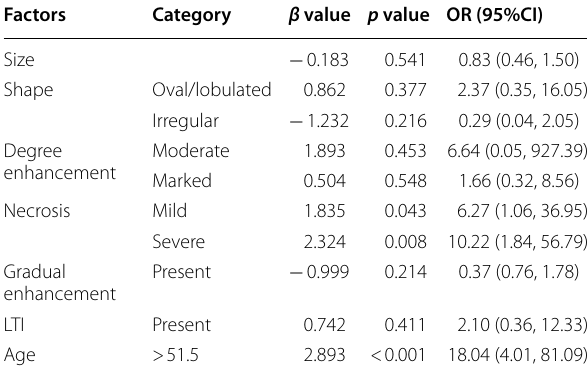
LTI, local tumor invasiveness